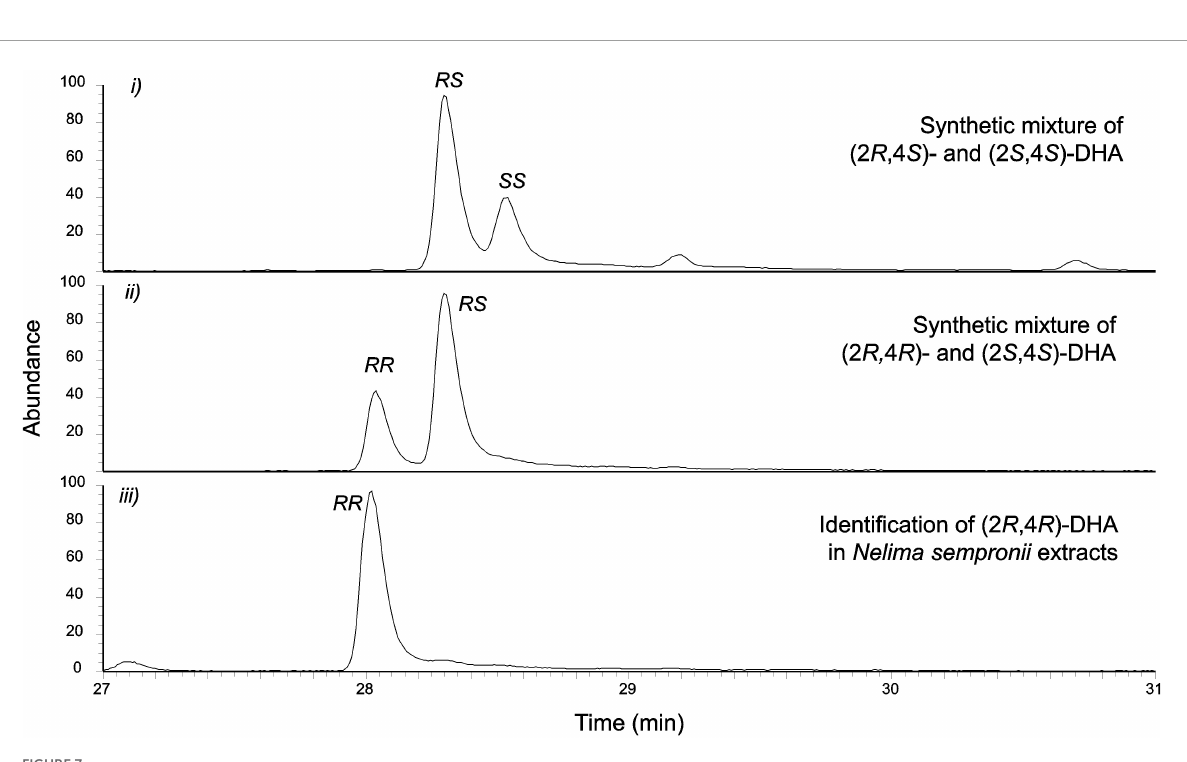
Frontiers in Ecology and Evolution